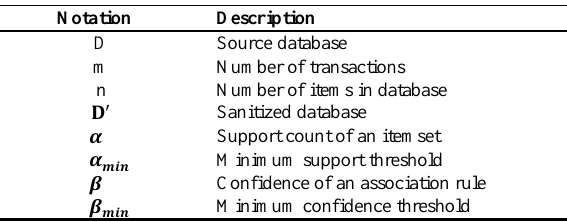
Table 1. Key notations.